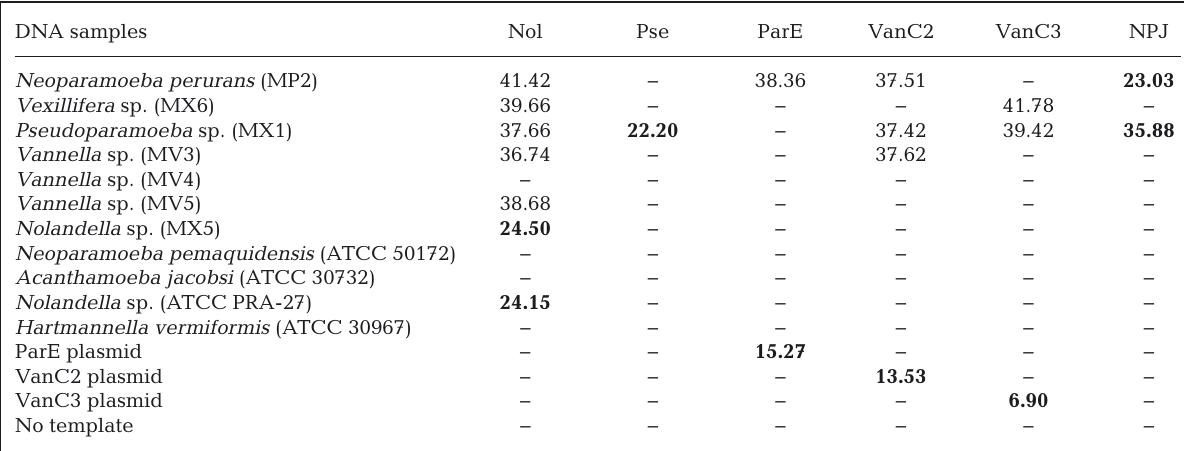
Table 4. Specificity of the 6 qPCR assays (see Table 3 for abbreviations) determined by testing each assay against various amoeba DNA samples listed as taxa (strain). Positive detections are indicated in bold . −: